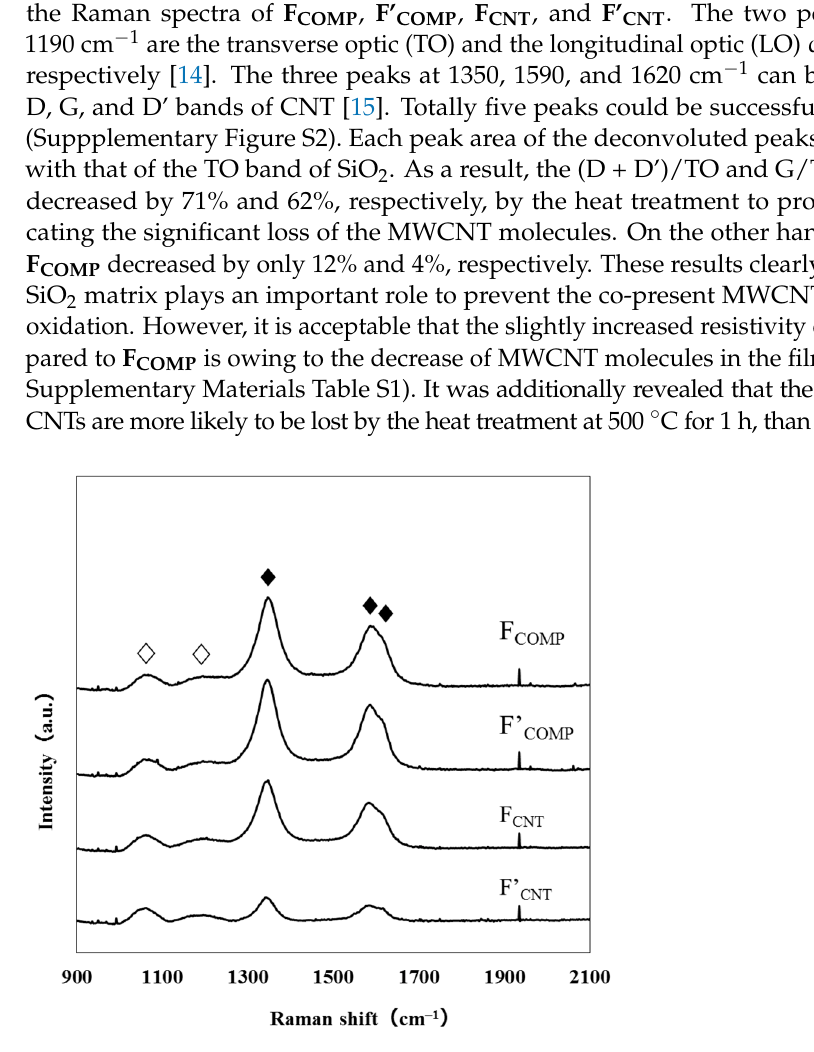
Figure 2. Raman spectra of the resultant thin films. The peaks attributable to the vibration modes for CNT and SiO 2 are represented by ♦ and ♢ , respectively.